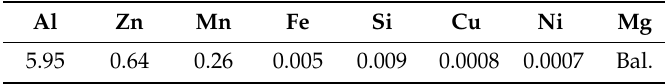
Table 1. Chemical composition of the AZ61